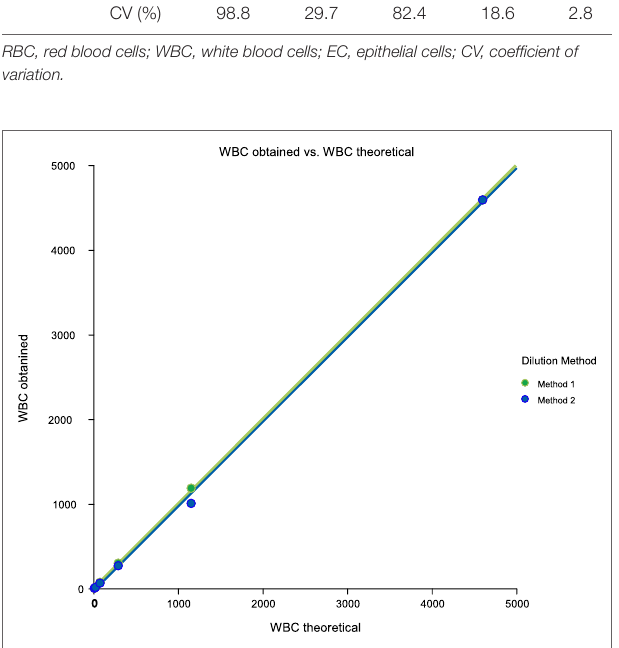
FIgURe 1 | Scatter diagram of obtained and theoretical white blood cell (WBC) in sample 1.